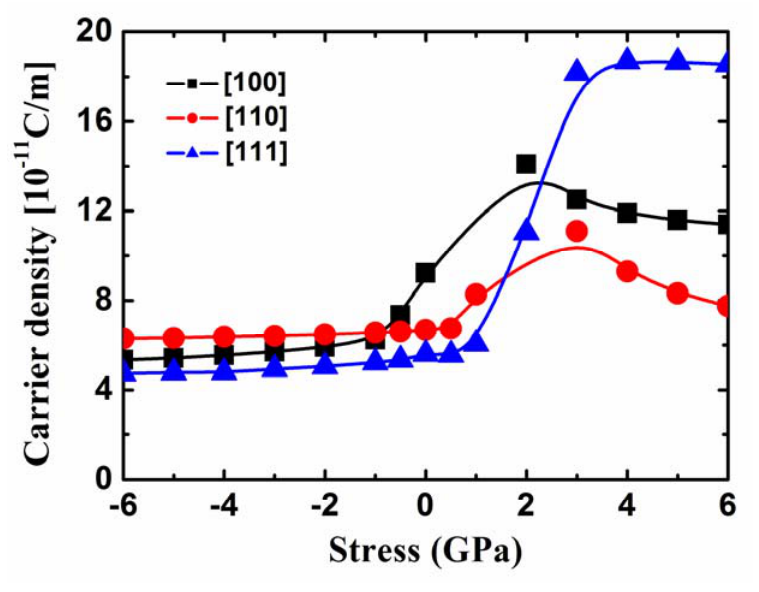
Figure 11. Carrier density of the p-type 5 nm square SiNW FETs as a function of the